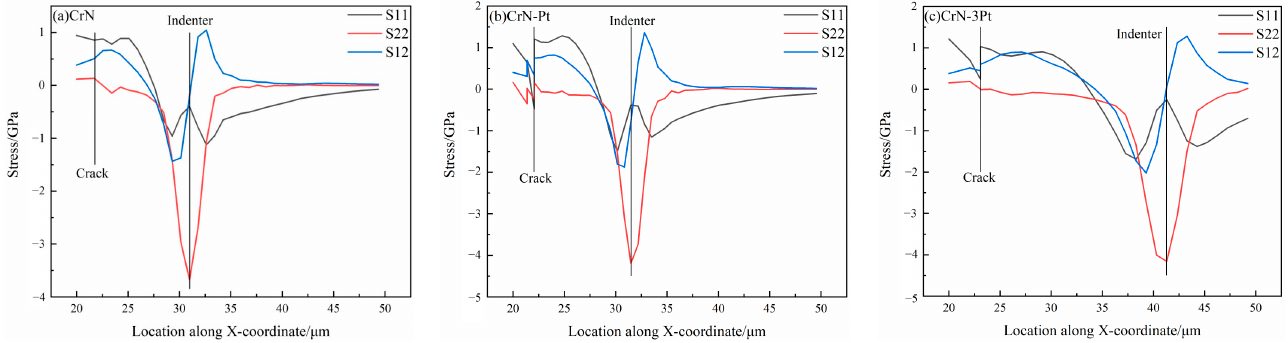
Figure 7. Anisotropic stress distribution in the middle of the three coating cracks when the crack propagates to half of the coating thickness. ( a ) CrN; ( b ) CrN-Pt; ( c ) CrN-3Pt.